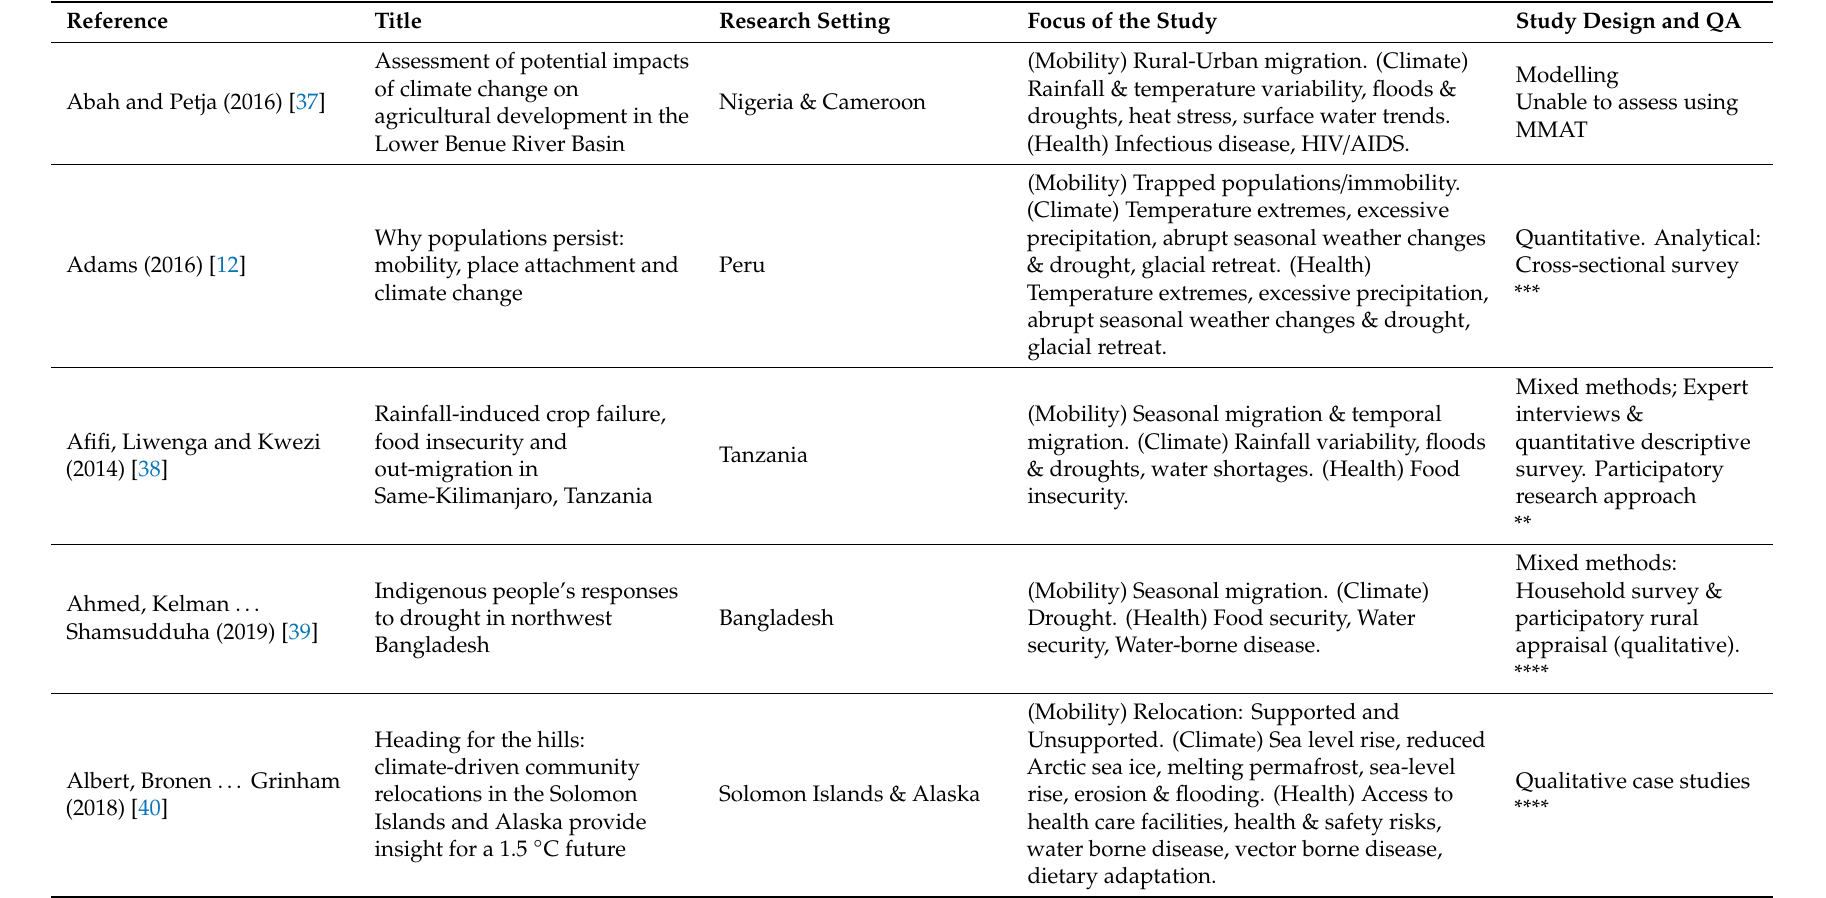
Table 3. Overview of selected studies with quality